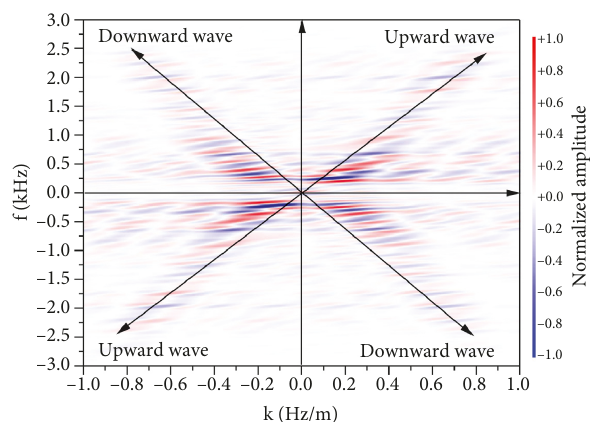
Figure 10: Results of the frequency-wavenumber domain analysis of the test data.